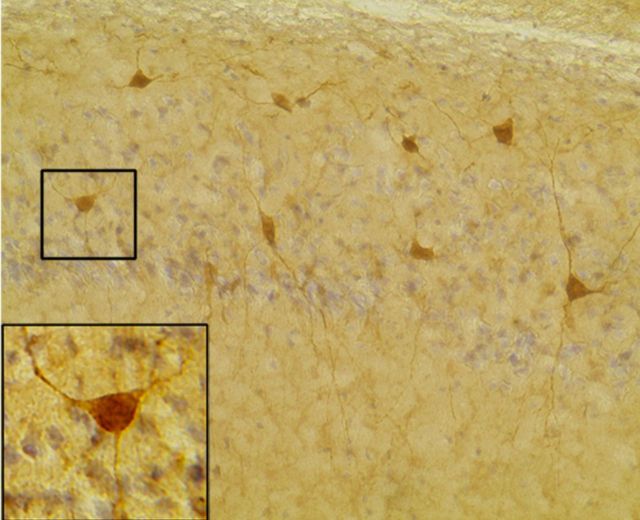
Post-translational modification of tau is common in human tauopathies. Bondulich et al. generate transgenic mice expressing low levels of a truncated form of tau (Tau35) that is associated with human tauopathy. Tau35 mice develop progressive tau neuropathology and cognitive impairment, modelling human disease. The approved drug 4-phenylbutyrate rescues these abnormalities.